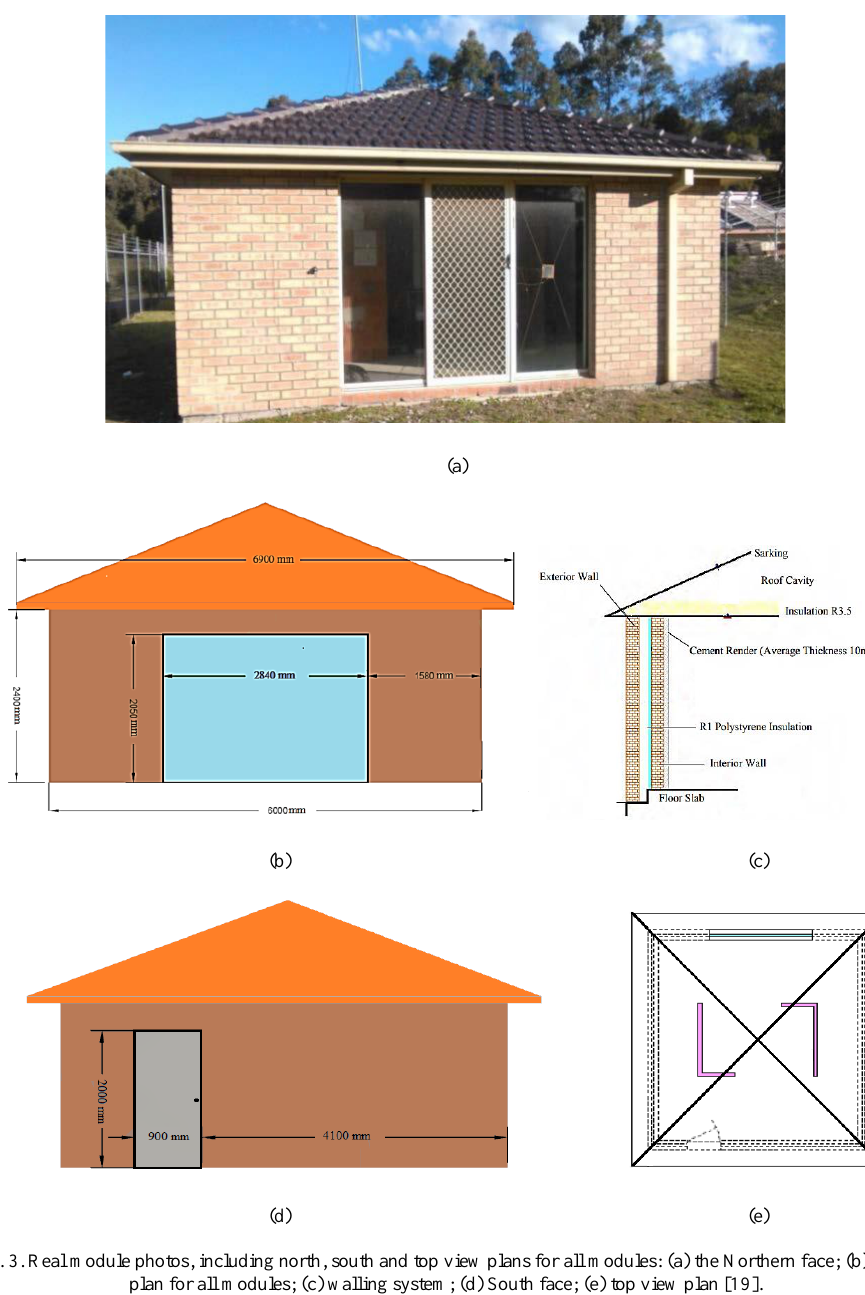
Fig. 3. Real module photos, including north, south and top view plans for all modules: (a) the Northern face; (b) North plan for all modules; (c) walling system; (d) South face; (e) top view plan [19]. The details of the wall systems used are summarised in Table